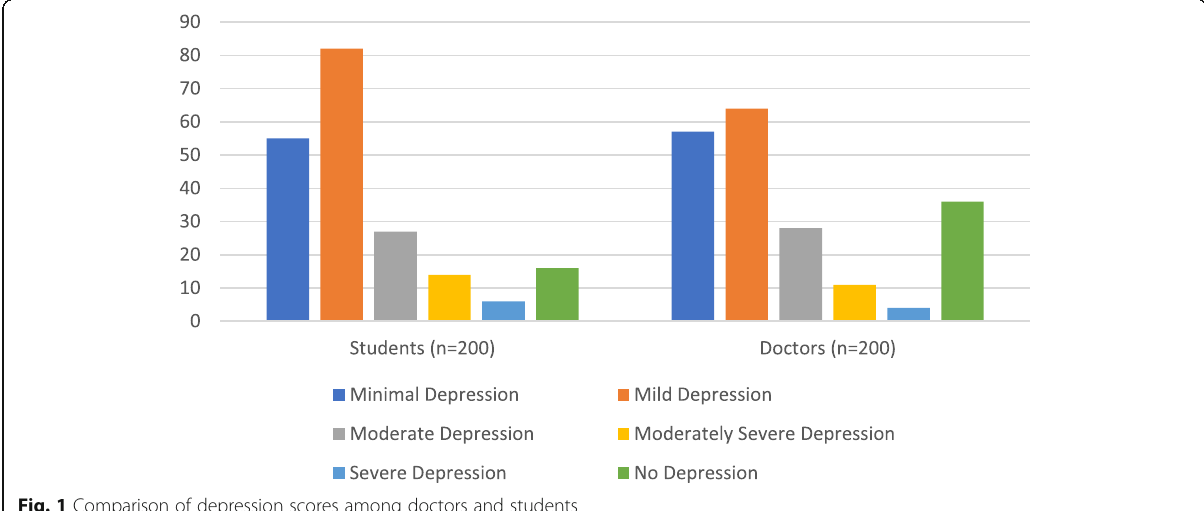
Fig. 1 Comparison of depression scores among doctors and